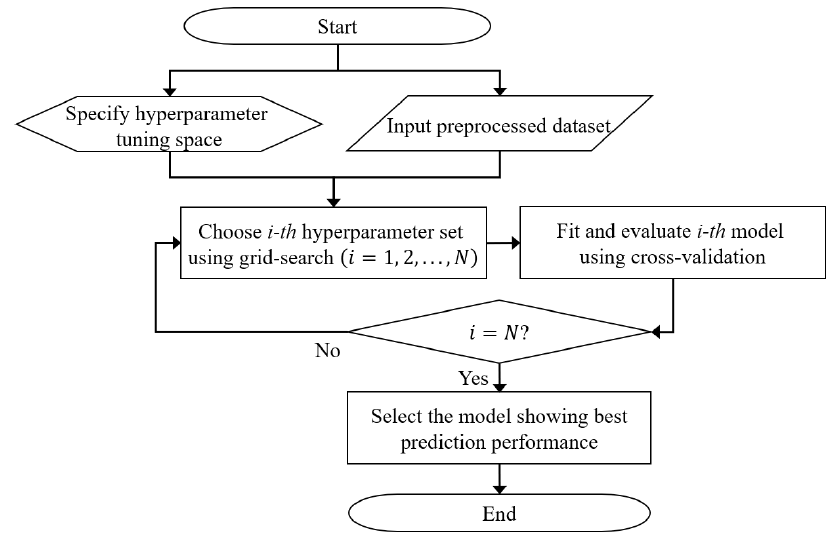
Figure 2. ARIMAX-based algorithm for constructing model.